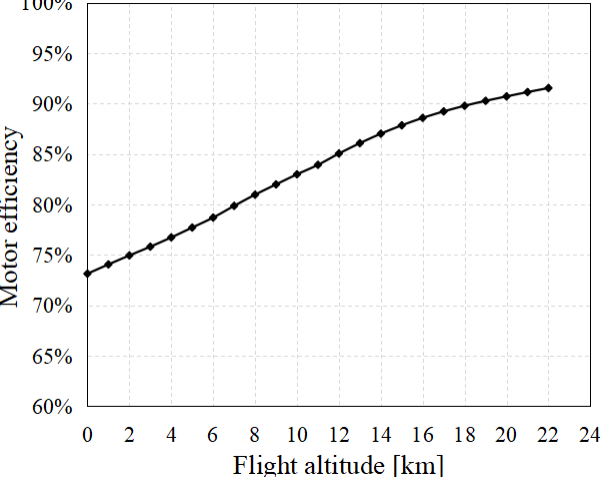
Figure 14. Change in motor efficiency under different working conditions.